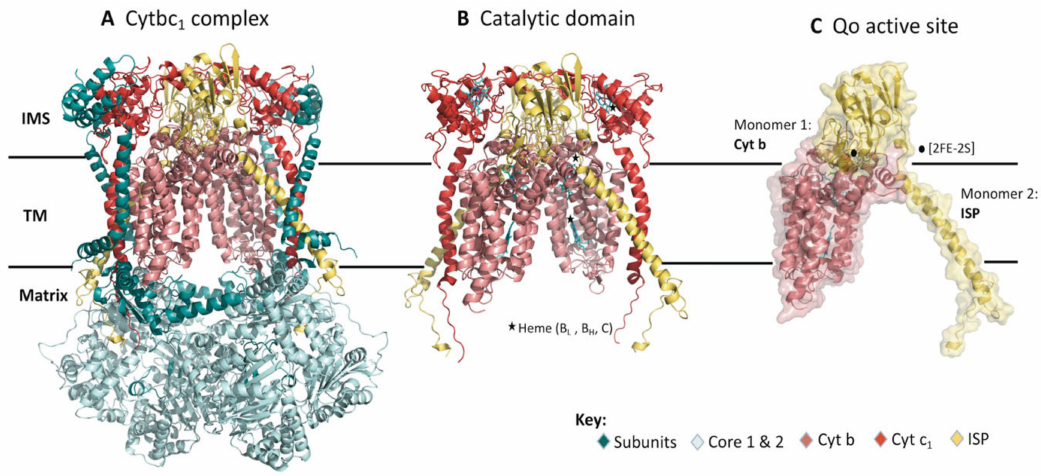
Figure 1. The structural model of the dimeric bc 1 complex in bovine (PDB ID: 1PP9). ( A ) The crystal structure in cartoon representation showing the multi-subunit dimer. The different subunits are color coded (key provided) and labeled accordingly. ( B ) Catalytic domain composed of Cytb, cyt c 1 and ISP spans across the inner mitochondrial membrane. ( C ) Heterodimeric structure made up of Cytb and ISP both of which form the Qo active site. Black stars and circles represent the hemes and [2FE-2S] cluster, respectively. (IMS—Intermembrane space,